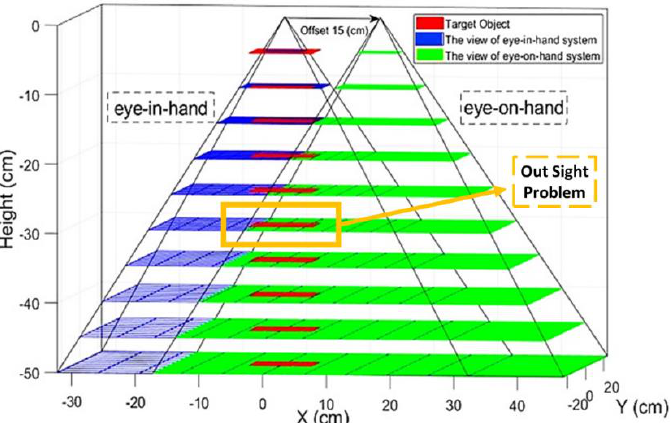
Figure 2. The out-sight problem of the eye-on-hand system with a 10 mm × 10 mm